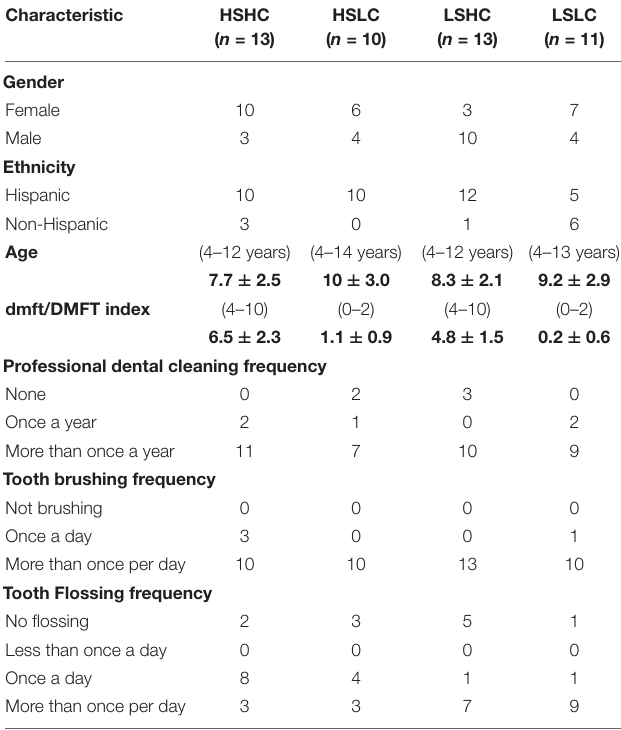
TABLE 1 | Demographic and oral hygiene information from the clinical study questionnaire.